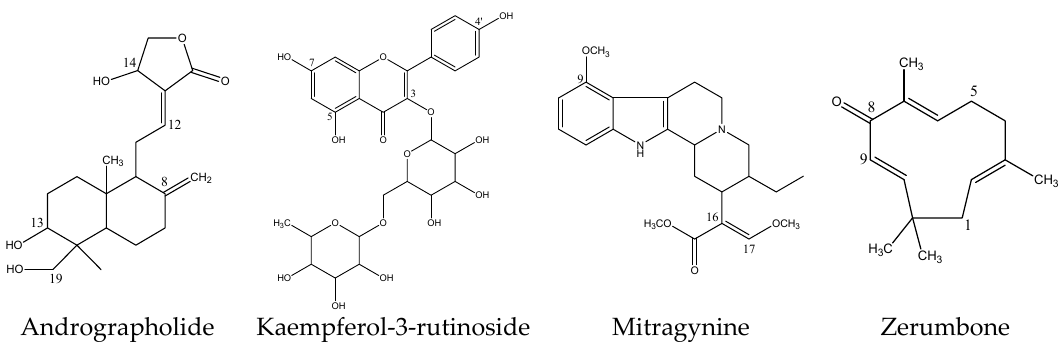
Figure 8. Chemical structures of inhibitory herbal bioactive constituents on UGT2B7 enzyme.